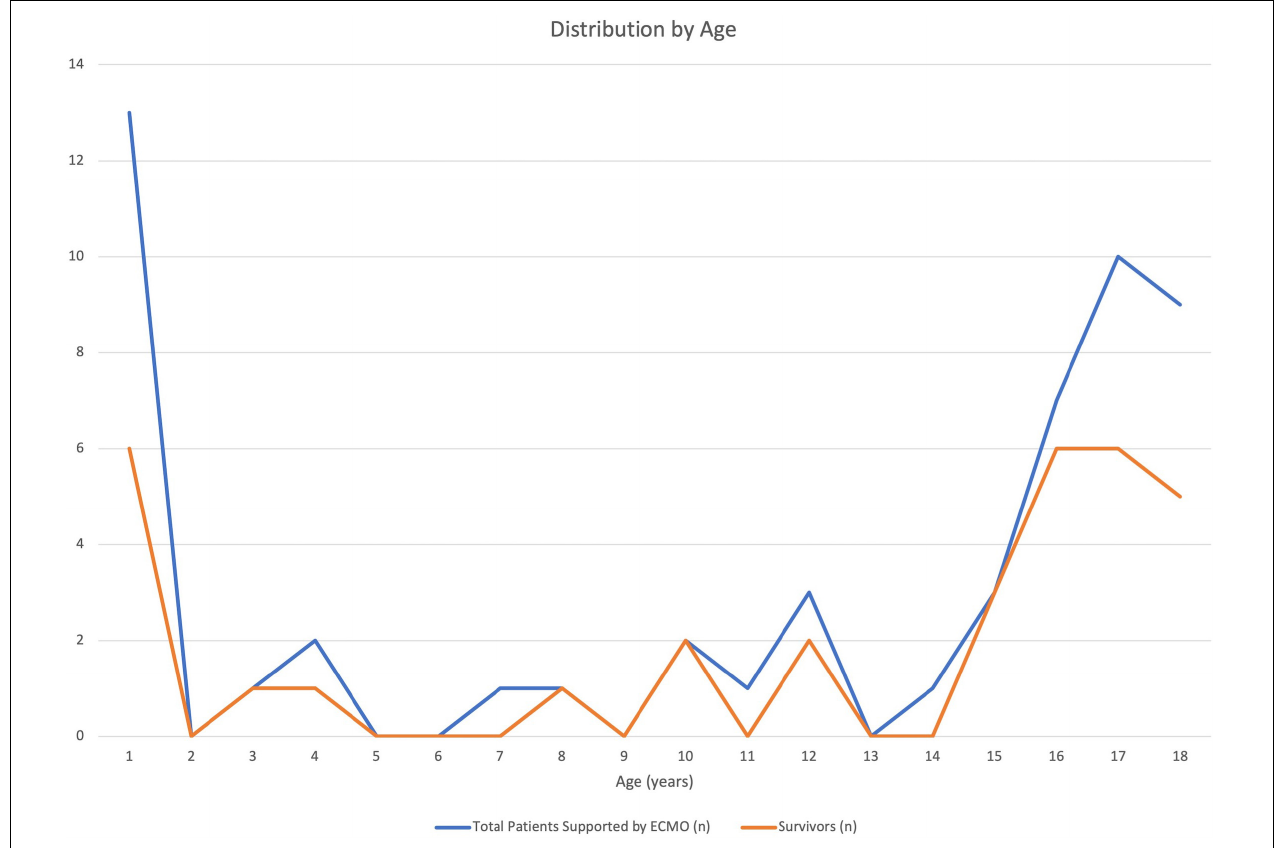
FIGURE 1 | Distribution of patients in the Extracorporeal Life Support Organization (ELSO) database with a primary diagnosis of pulmonary embolism by age during the study period (2007–2018). Total patients and survivors (n) displayed by year of life.